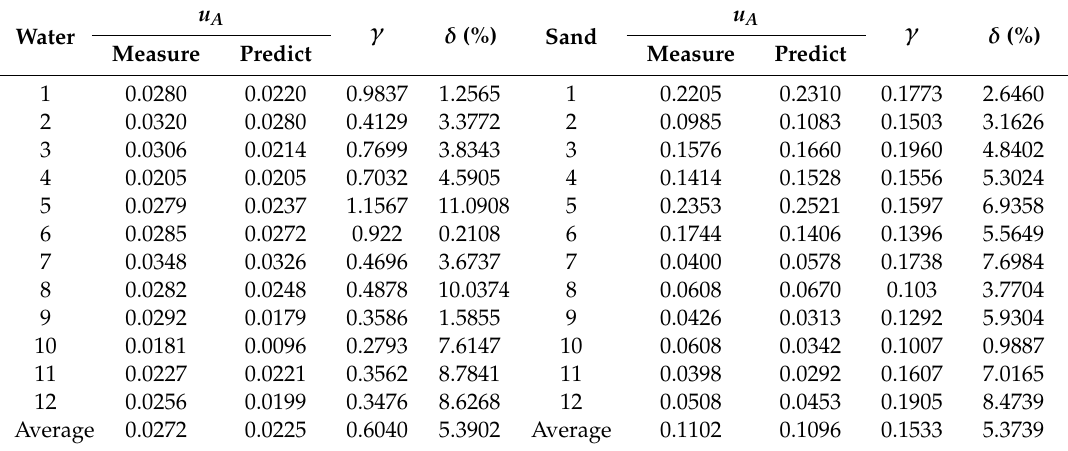
Table 2. Comparison of the root means square error of mass flow rate and relative error of the total mass.